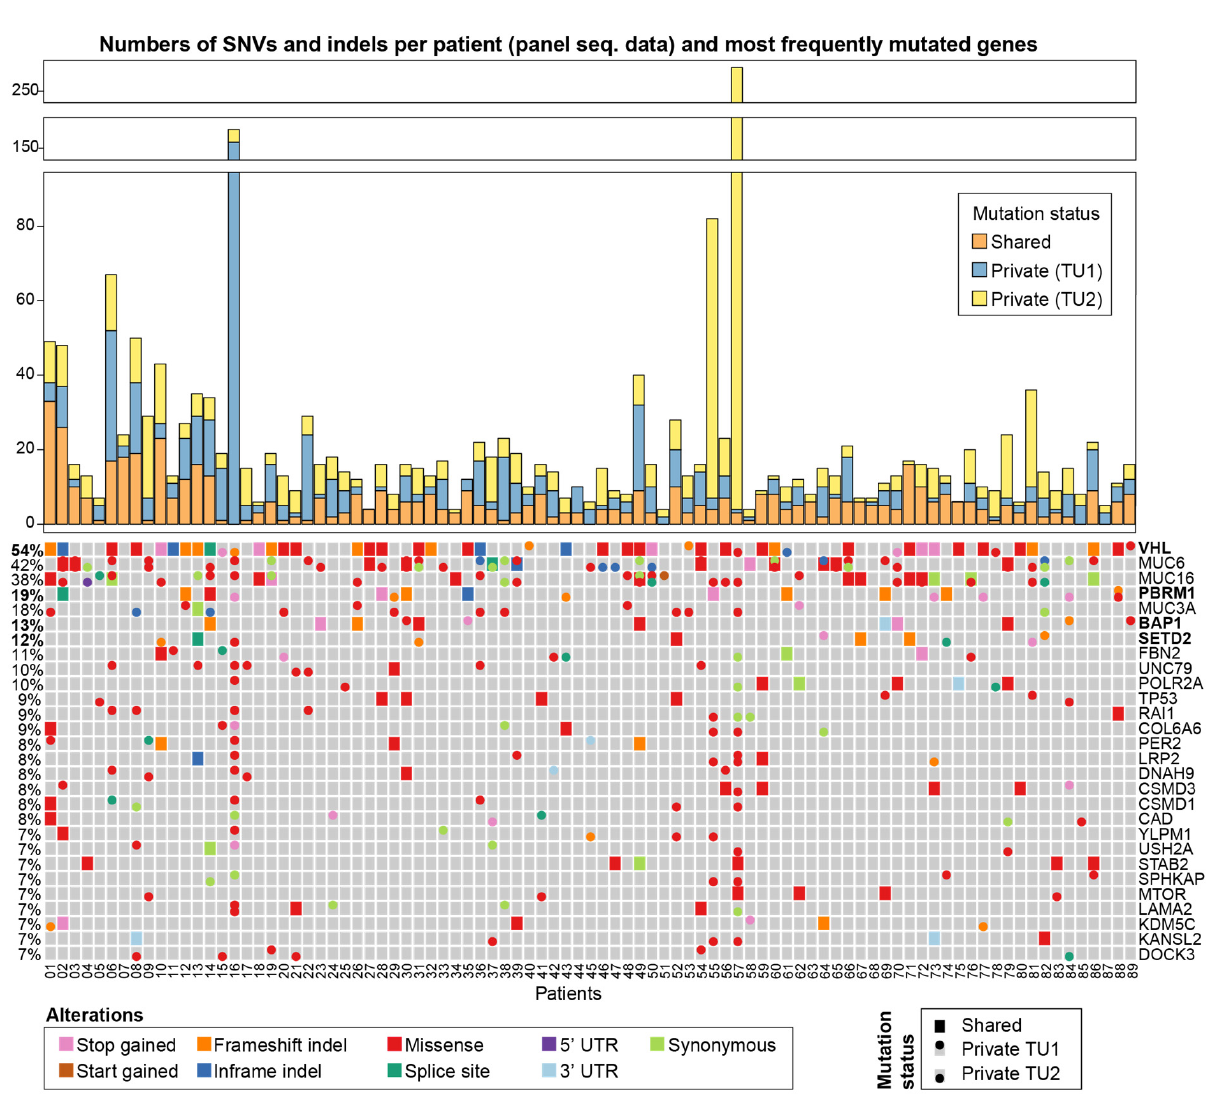
Figure 3. Genetic diversity in the panel seq data of 89 ccRCC patients. Top: numbers of shared and private mutations in the data set. Bottom: the heatmap highlights the mutations that were detected in the most frequently mutated genes. The four most frequently altered genes in ccRCC are VHL , PBRM1 , BAP1 , and SETD2 [17] and are highlighted in bold. If a gene was hit by multiple mutations that all have the same status (shared, private TU1, or private TU2), the following ordering is applied to prioritise which colour is shown in the heatmap, starting with the highest priority: stop gained, start gained, frameshift indel, inframe indel, missense, splice site, five prime UTR, three prime UTR, synonymous. That means, if a gene has, e.g., a missense and a synonymous mutation, the missense mutation will be displayed in the heatmap. The variants were annotated with SnpEff [22] (Supplementary Table S2). Mutations in non-coding regions are omitted from the heatmap.